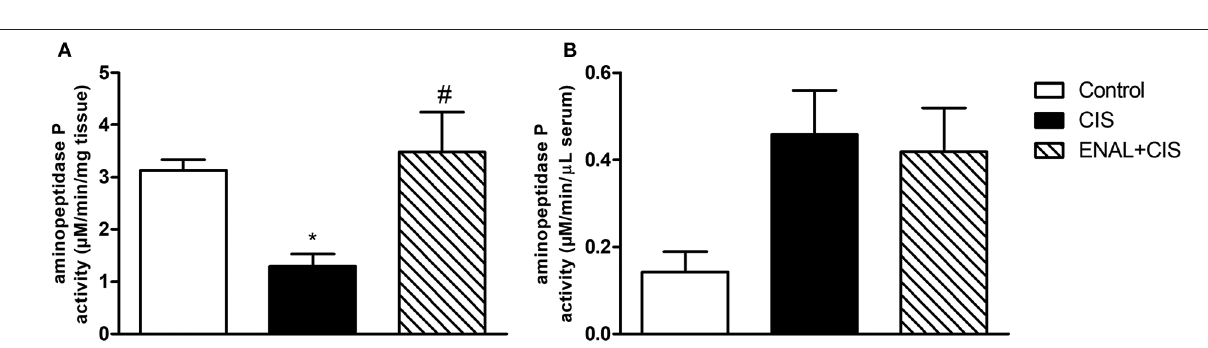
FIGURE 4 | Renal and serum aminopeptidase P activity. Enalapril treatment prevents reduction in aminopeptidase P activity in kidney (A) , no alterations were found in aminopeptidase P activity in serum (B) 4 days after cisplatin injection. * p < 0.05 compared to the control group; # p < 0.05 compared to the CIS group. Data presented as Mean ± SEM; n = 6 per